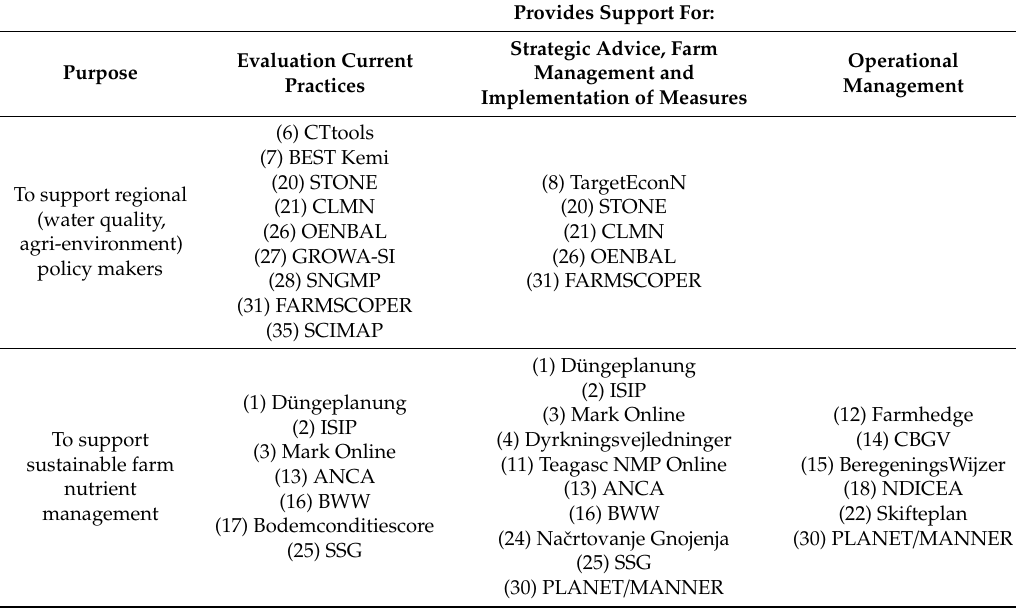
Table 1. Classification scheme for nutrient management DSTs (numbers in brackets refer to the DST number in Table A1).